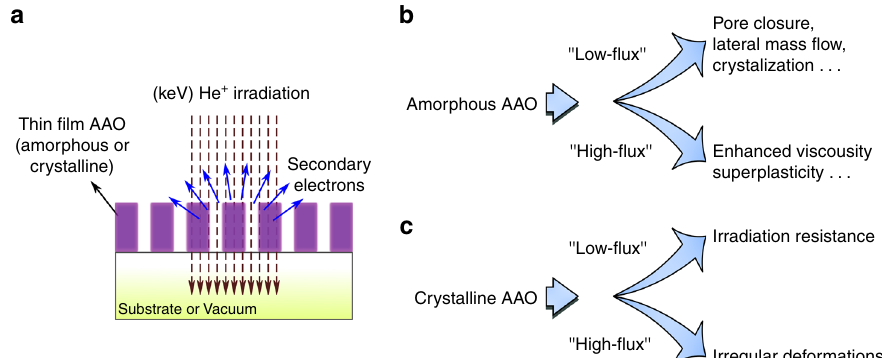
Fig. 1 Interaction of helium ions with nanoporous AAO. a Shows the principles of the experimental setup. Helium ions with keV energy are generated in a gas fi eld ion source and then are scanned over the sample in a high vacuum chamber. Secondary electrons that are generated by the sample are used for in situ monitoring of the ion-beam interactions with <1 nm resolution. The studied samples are thin fi lms of nanoporous membranes of aluminum oxide (either supported by a substrate or locally stand free in vacuum). b , c Symbolic illustration of observed phenomena: the microscopic response of the matter to irradiation is determined by the interplay between the nature of the chemical bonds, ionization effects, and irradiation-induced